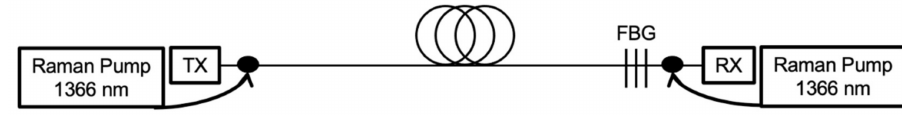
Figure 1. Raman fiber laser-based amplifier with a half-open cavity random lasing.